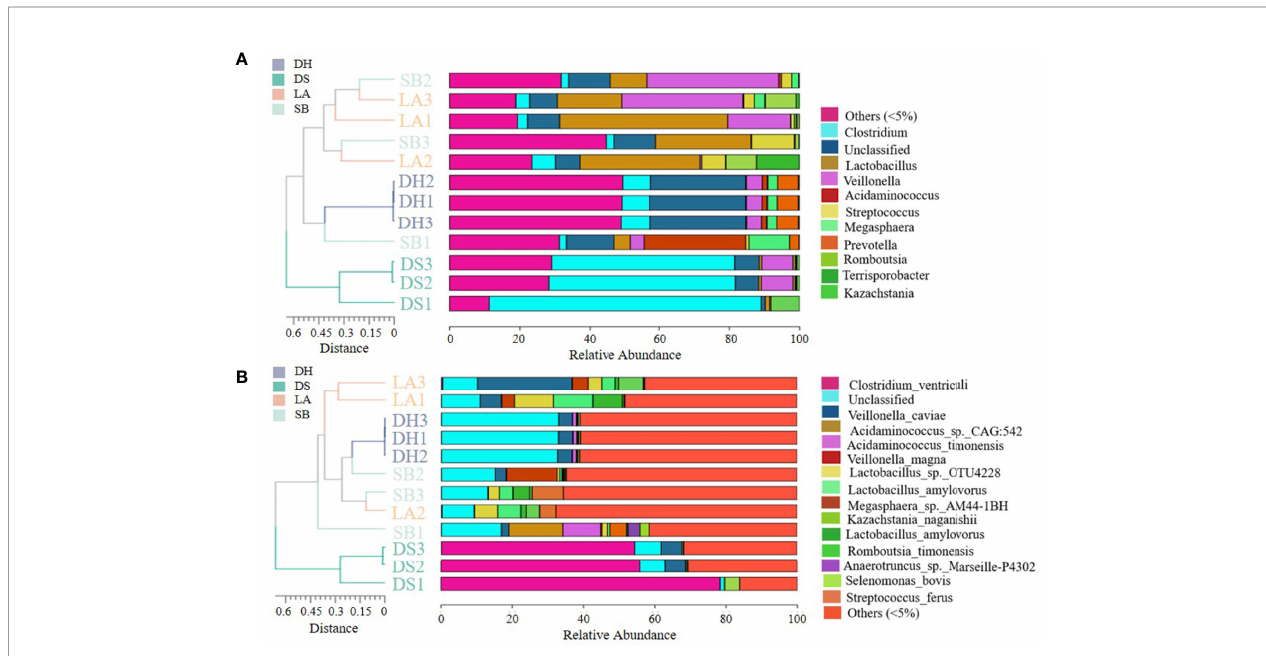
FIGURE 2 | Unweighted pair-group method with arithmetic mean (UPGMA) clustering tree. Relative abundance and similarity of bacterial communities with abundance greater than 5% at genus (A) and species (B) level. Sequences that could not be classi fi ed into any known group were grouped as “ unclassi fi ed ” , and sequences detected with low abundance were grouped as “ others ” .